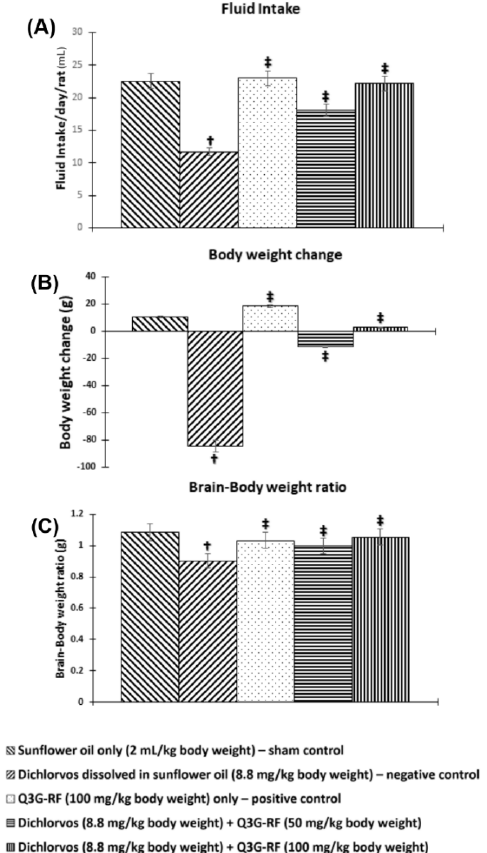
Figure 1. Influence of Q3G-RF from S. mombin leaves on feeding and anthropometric indices. Fluid intake ( A ), body weight difference ( B ) and brain/body weight ratio ( C ) of Wistar rats treated with sunflower oil, DDVP alone, Q3G-RF alone, and DDVP + Q3G-RF (50 and 100 mg/kg). Values are expressed as mean ± standard error of mean ( n = 10). Significant differences from the positive control group are indicated by † and from DDVP alone by ‡ , ( p < 0.05). DDVP, Dichlorvos; Q3G-RF, Quercetin-3-O- β -D-glucopyranoside-rich fraction from Spondias mombin .